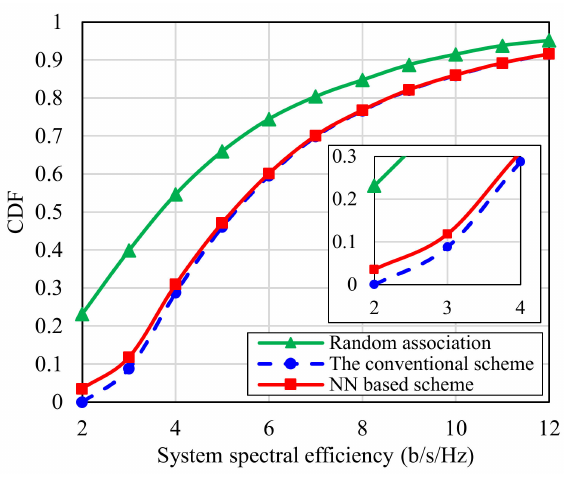
Figure 10. CDF of spectral efficiency using the proposed NN based scheme, the conventional exhaustive search based scheme, and random association based scheme.